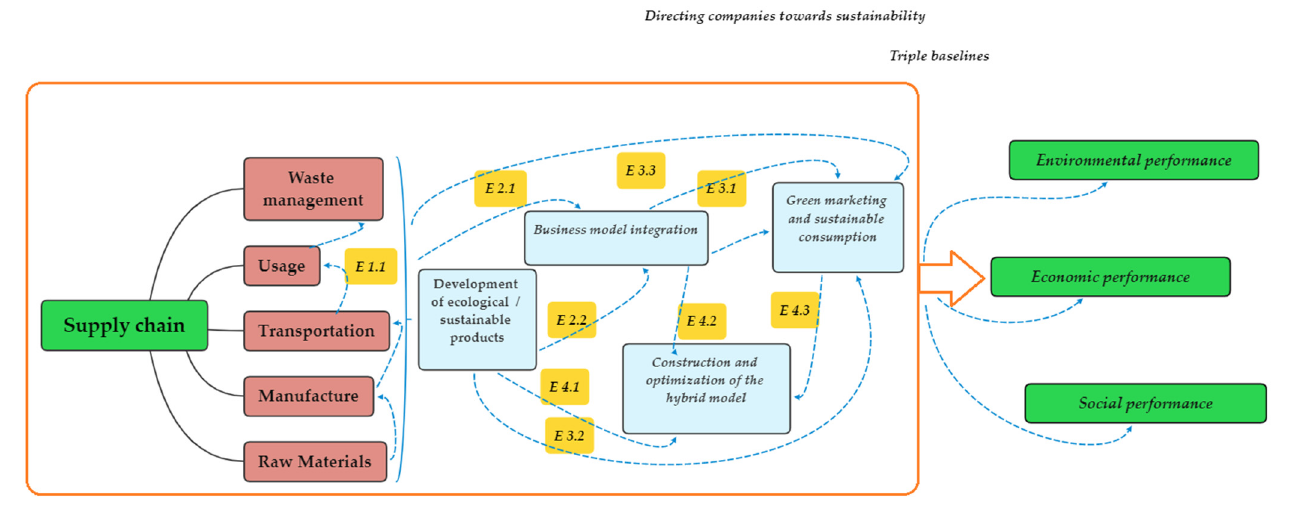
Figure 3. Evolution of companies over time towards sustainability [24] (Authors’ own